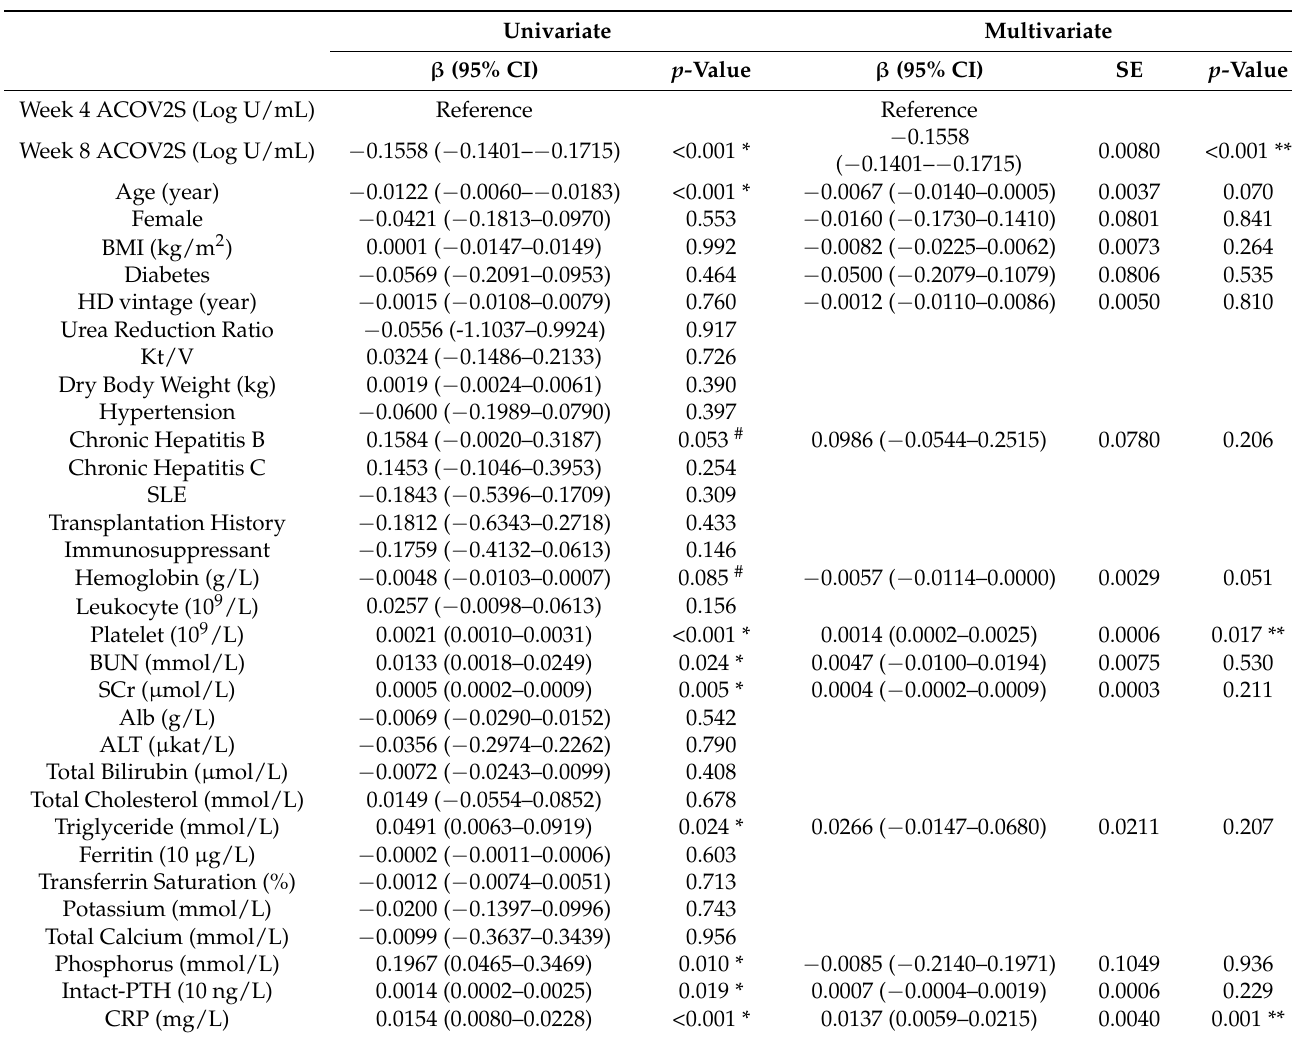
Table 4. Factors Associated with Antibody Waning after Vaccination in HD